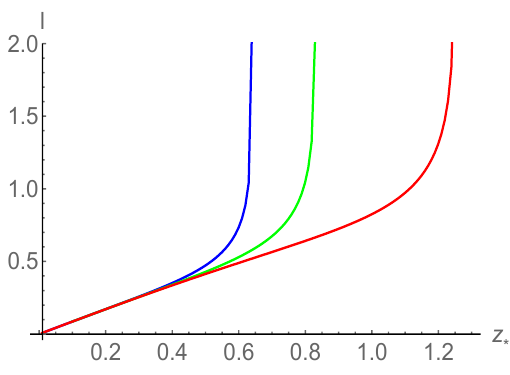
Figure 14 . ‘ as a function of z (cid:3) in the decon- (cid:12)nement phase. Here (cid:22) = 0 and red, green and blue curves correspond to T=T c = 1 : 2, 1 : 6 and 2 : 0 respectively. In units GeV.